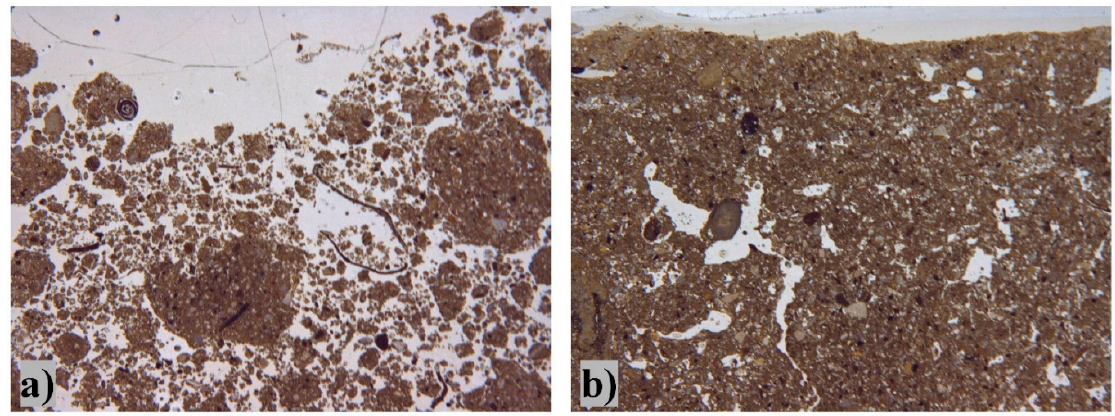
Figure 3. Macrophotographs of soil thin sections of a topsoil horizon one month after tillage without rainfall event ( a ), and the same soil 3 months after tillage and intense rainfall events ( b ). The horizontal length of a section is 32 mm.